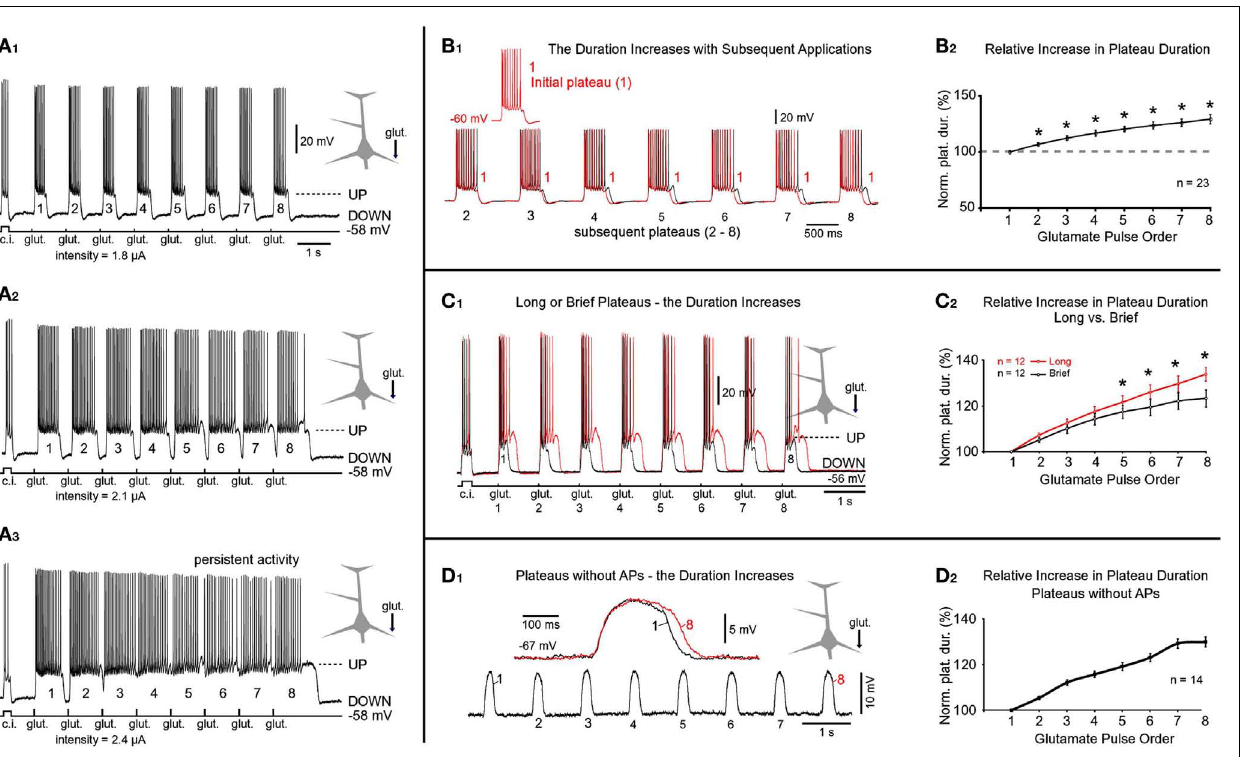
glutamate pulses; duration = 5ms each] were delivered on one basal dendrite and evoked potentials were recorded in the soma.The stimulus intensity was then reduced to shorten the duration of plateaus by ∼ 50% (black trace). (C 2 ) Red graph : plateau durations were normalized against the first plateau in the sequence and averaged across 12 cells using traces with long plateaus ( ∼ 500ms). Black graph : traces with brief plateaus ( ∼ 250ms) from the same 12 cells were normalized and averaged. ∗ p < 0.05, the corresponding plateaus were compared using paired t -test. (D 1 ) Same experimental setting as in (A 1 ) except plateau depolarizations did not trigger somatic action potentials. Inset: the first and the eighth plateaus are superimposed on a faster time scale. (D 2 ) Plateau durations were normalized against the first plateau in the sequence and averaged across 14 cells using traces with 8 spikeless plateaus.